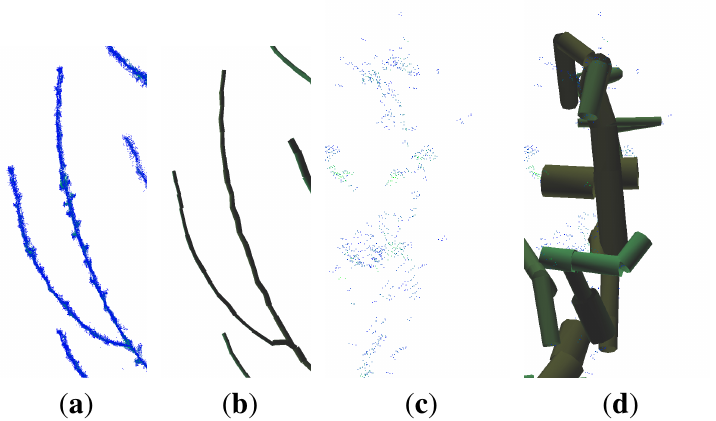
Figure 4. Impact of scan quality on the modeling of twig wood: (a) sub-point cloud of high quality of a P. avium presented in Hackenberg et al. [5]; (b) the modeled twigs; (c) sub-point cloud of low quality of Q. petraea Q#8; (d) erroneous twig cylinders with an overestimated diameter in this section of the